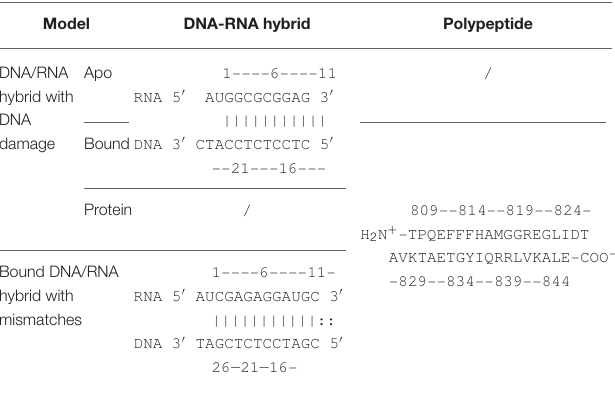
Model DNA-RNA hybrid Polypeptide DNA/RNA hybrid with DNA